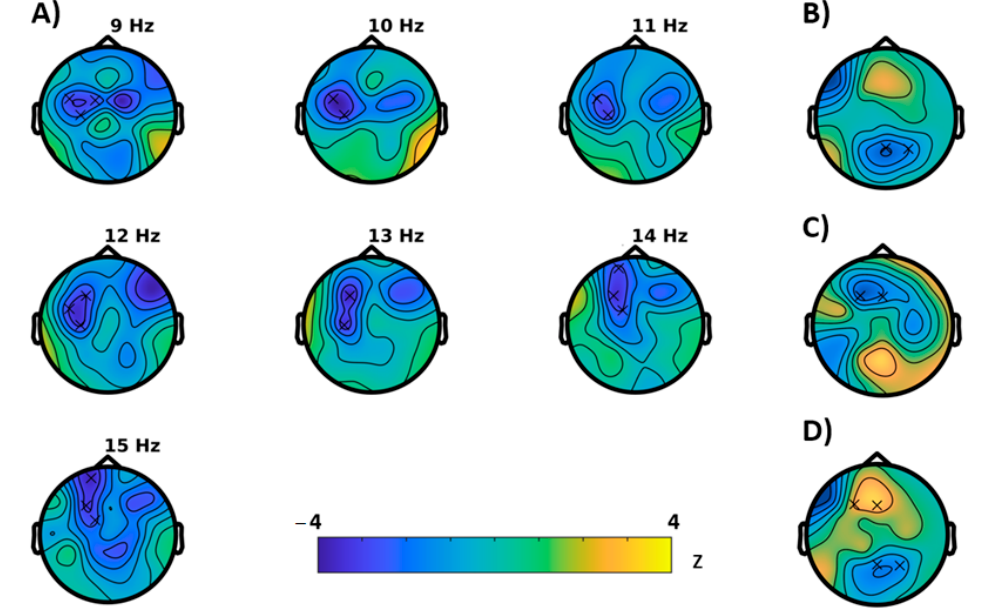
Figure 5. Results of the cluster based permutation tests for the incongruent trials of the Simon task (BASELINE vs MONTELUKAST, cluster corrected, x = p < 0.05). ( A ) Cluster for spectral power, ( B ) brain-rate, ( C ) entropy, ( D ) Hjorth mobility.